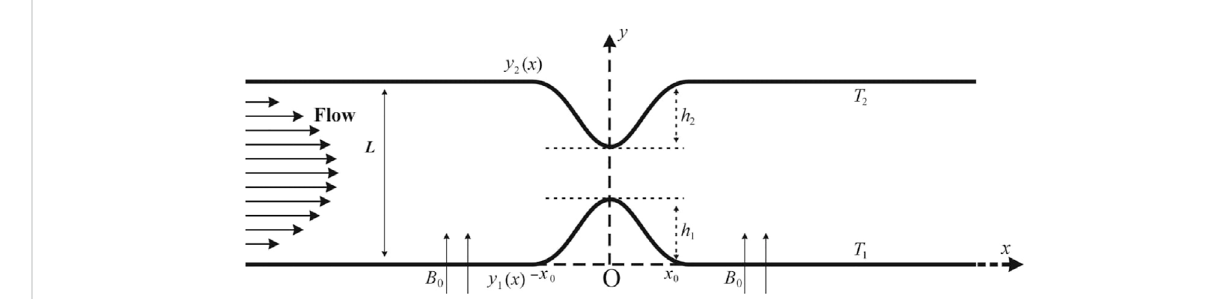
The channel geometry with a constriction on each wall. The walls are de fi ned by.